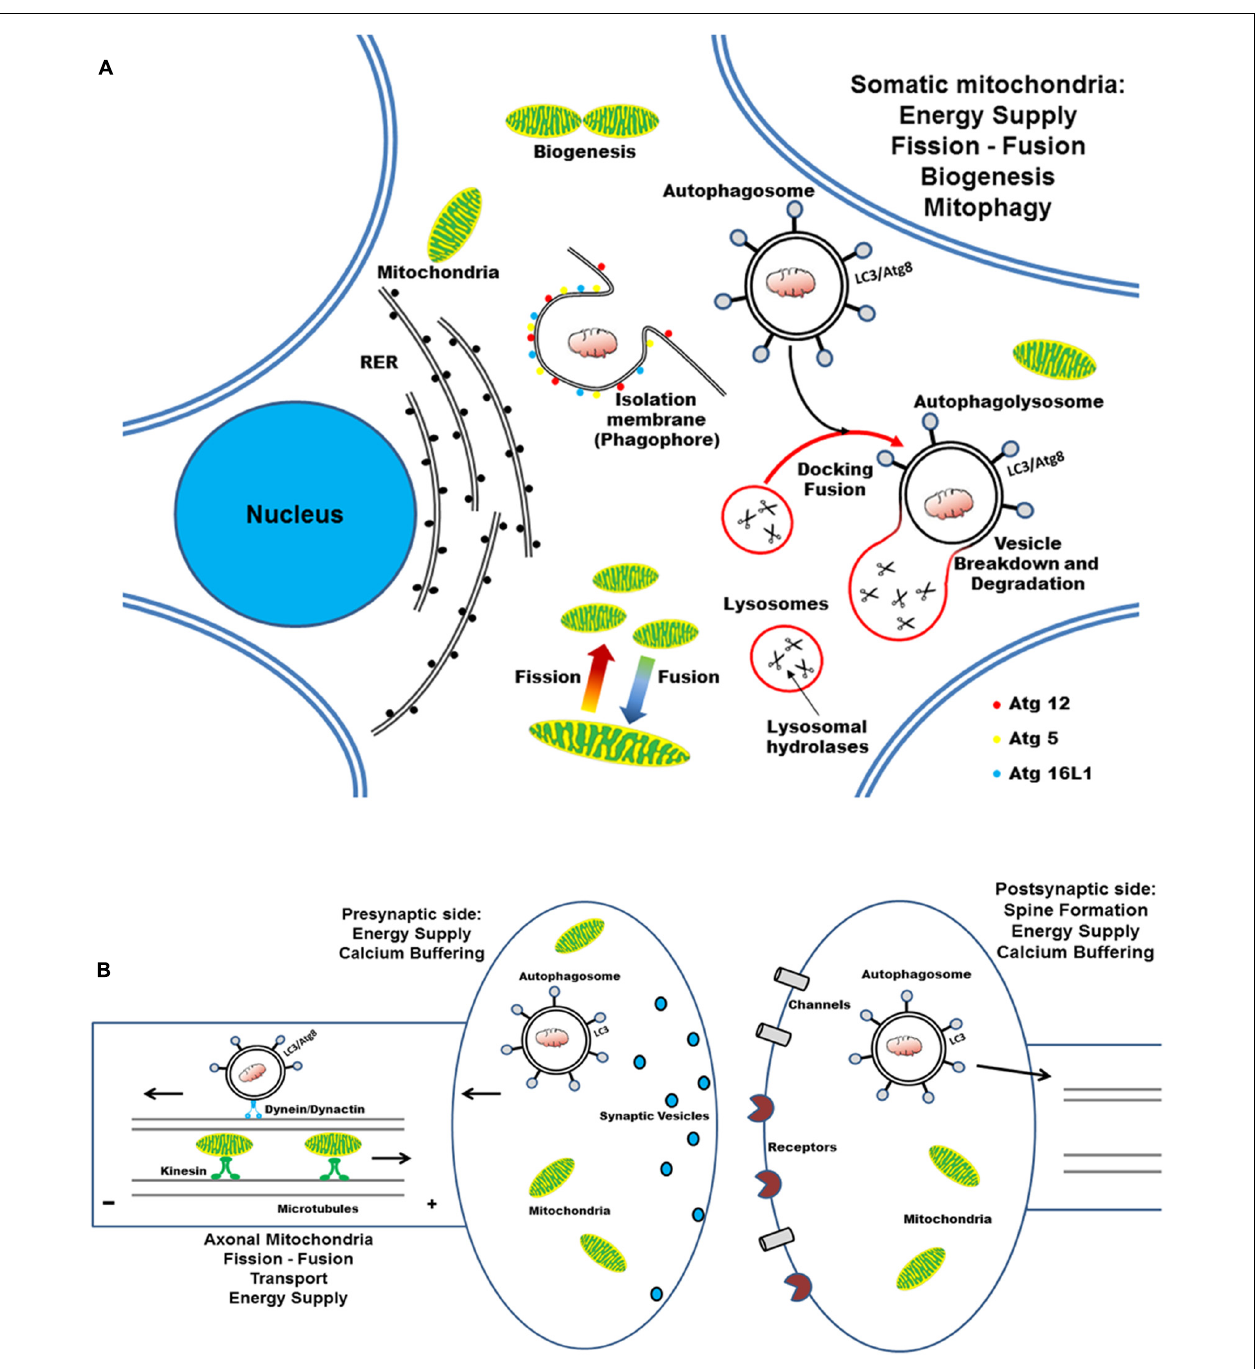
FIGURE 4 | Cartoon illustrating the mitochondrial turnover which copes with the compartmentalized and distinct energetic requirements in the cell body, axon, and synaptic compartments of post-mitotic neurons. (A) In neurons, mitochondria travel long distances from the cell body out to distal dendritic and axonal terminals, where they subserve the ATP production and calcium homeostasis.The dynamic processes of biogenesis, fusion– fission regulate the mitochondrial function and quality control, by allowing them to adapt to spatial–temporal changes in cellular energy requirements. Selective autophagy begins with the nucleation of an isolation membrane (phagophore) which surrounds the damaged mitochondria to be degraded.